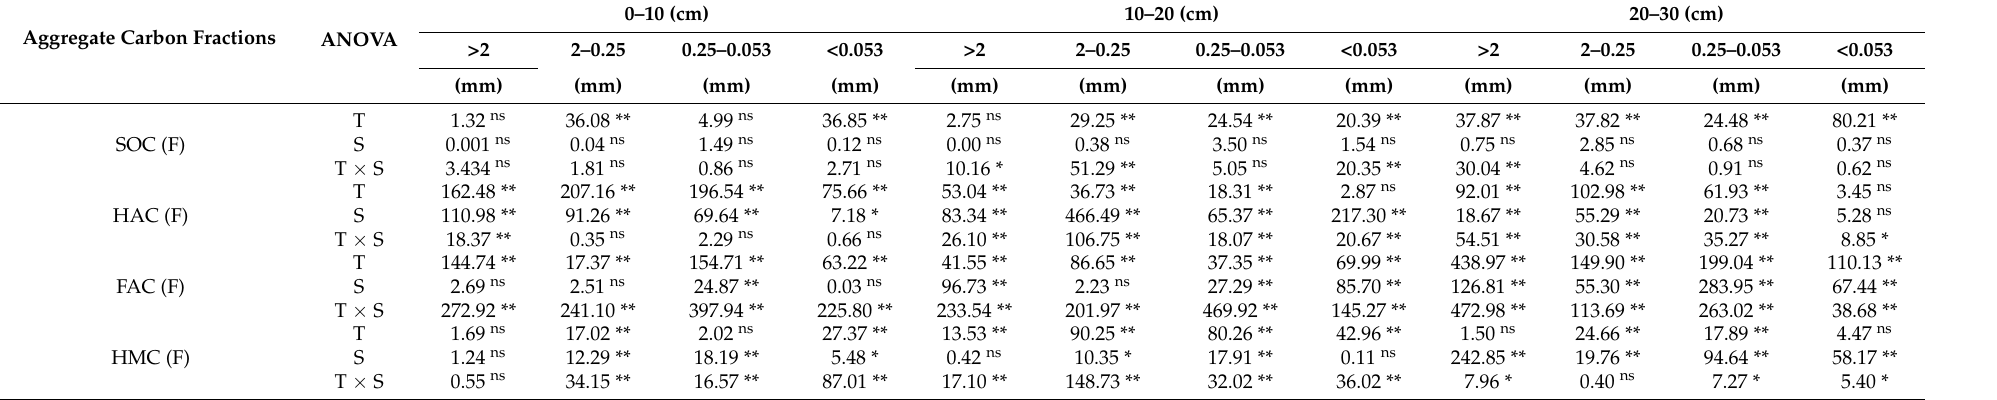
Table 3. Interaction of tillage and straw management on aggregate size-associated organic and humus